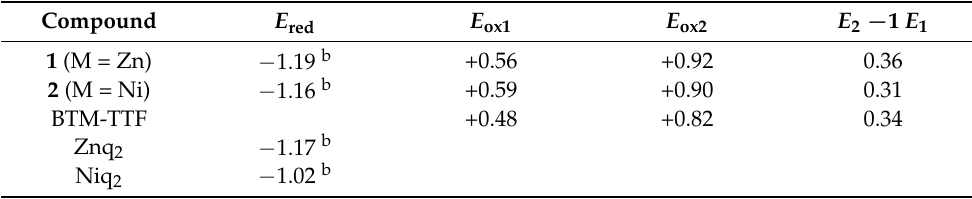
Table 1. Redox potentials (V) of 1 , 2 , BTM-TTF, Znq 2 and Niq 2 a .